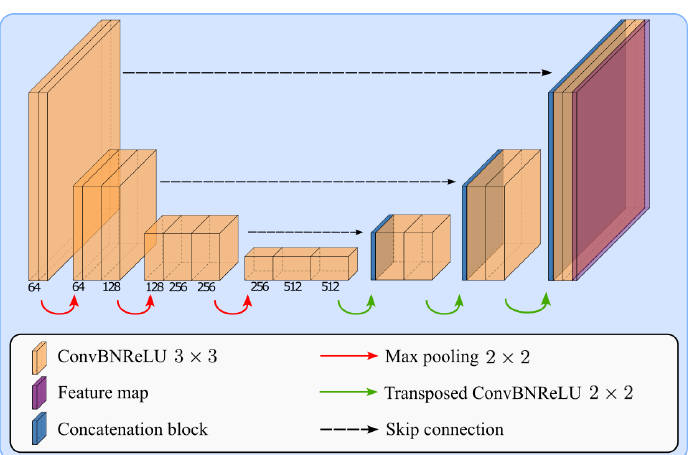
Figure 6. The U-Net architecture adopted in the FFT U-Net paper, here shown in a more shallow configuration for the sake of illustration. The actual network has four encoder-decoder